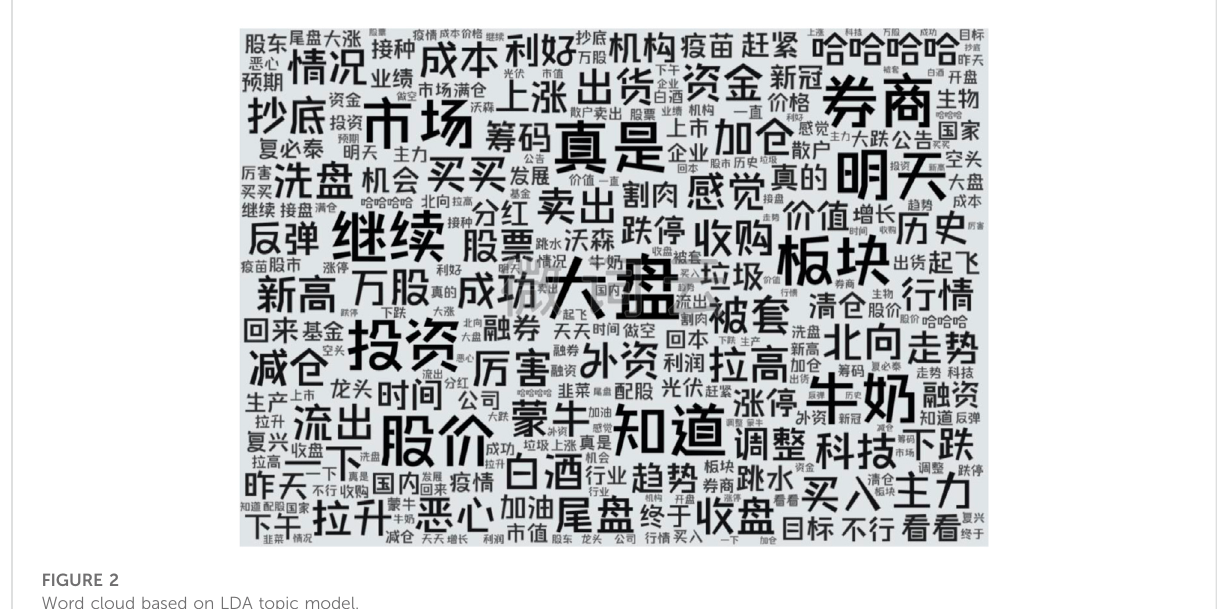
FIGURE 2 Word cloud based on LDA topic